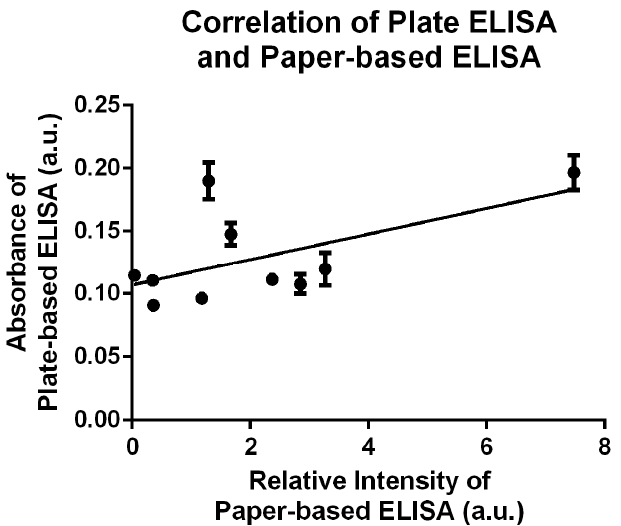
Figure 4. Correlation of the angiogenin detection between conventional plate ELISA and paper-based ELISA in burn blister fluids. The data show a moderate correlation between the results of P-ELISA and conventional plate ELISA ( r = 0.5906, p = 0.0722).